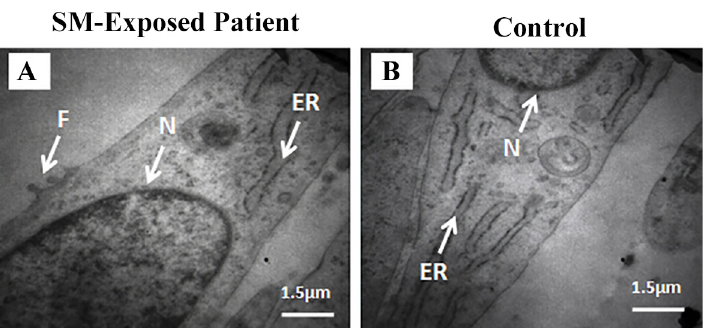
Fig 4. Electron microscopic photomicrographs of fibroblasts. SM-exposed patient and control (A and B). Filopodia are seen in SM-exposed fibroblasts. Abbreviations: SM sulfur mustard, ER endoplasmic reticulum, F filopodium, N